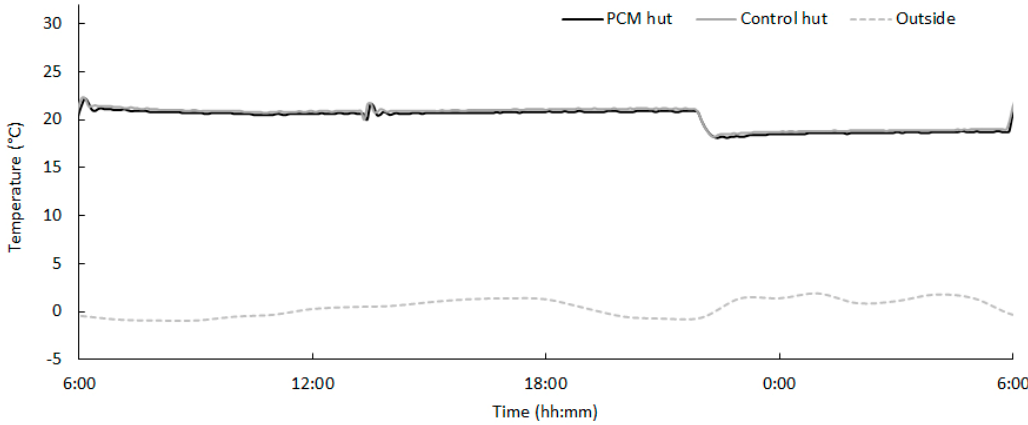
Figure 6. Dry temperature of the huts for a cloudy day of March (15/03/2018).